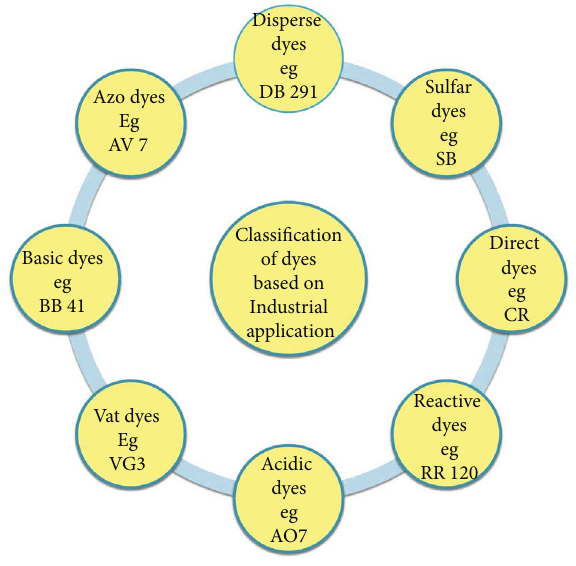
Figure 1: Classi fi cation of dyes based on their industrial